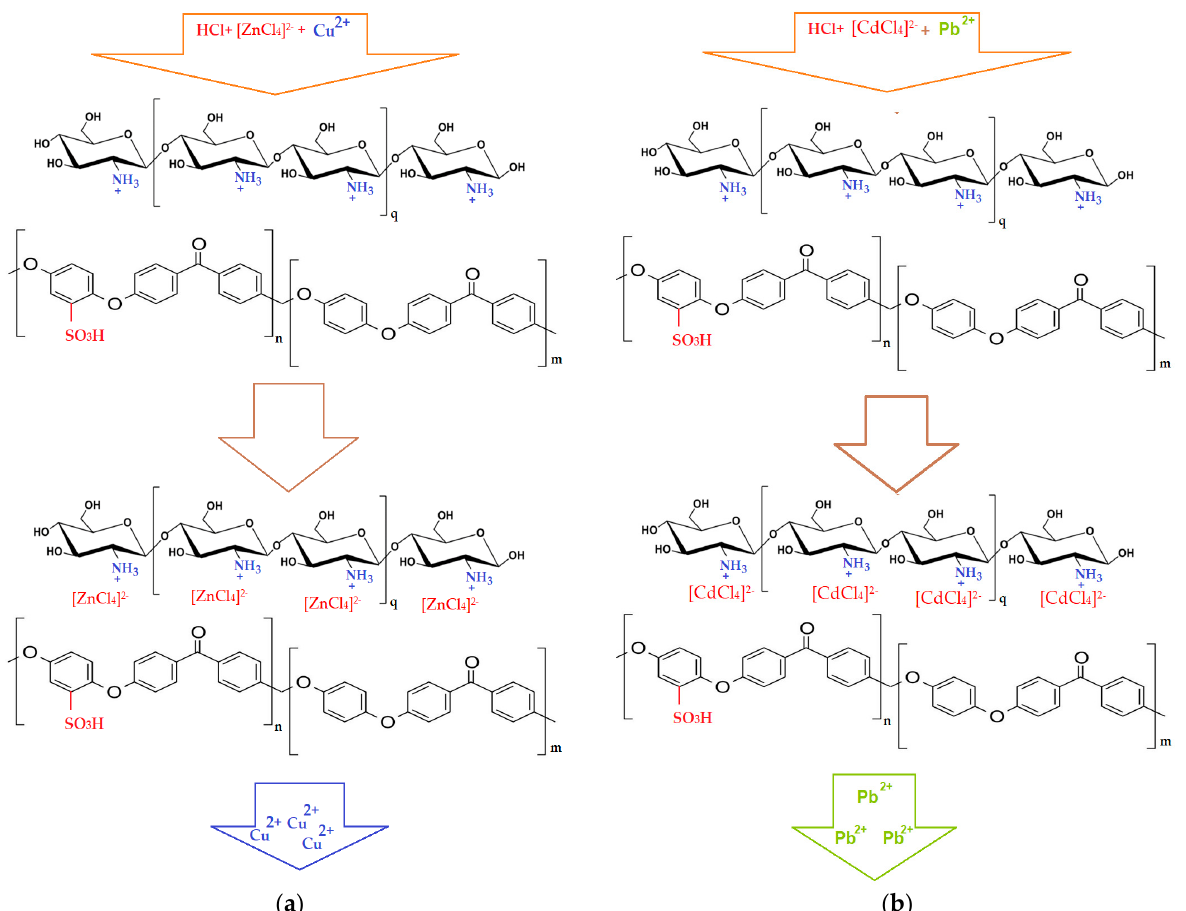
Figure 12. Separation of the mixture of copper and zinc ions or cadmium and lead with a strong acid solution (3 mol/L hydrochloric acid) by nanofiltration copper and zinc ions ( a ); and cadmium and lead ions ( b ).